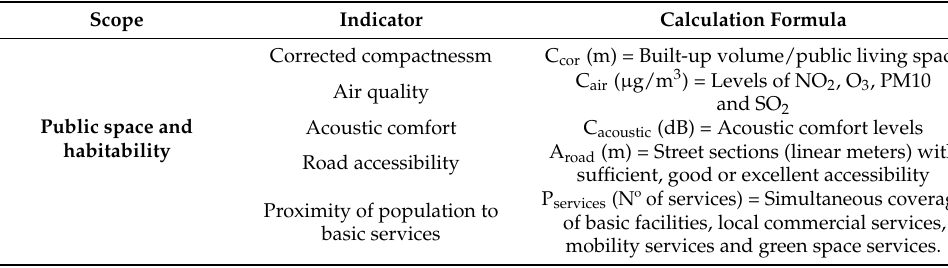
Table 4. Indicators used in the scope of public space and